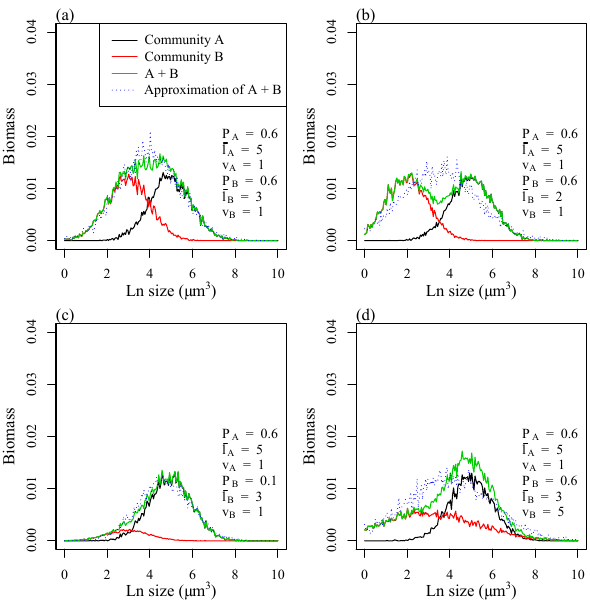
Figure 14. Schematic diagrams for the mixing of two phytoplank- ton communities with different biomass, mean size, and size vari- ance, each following a lognormal size